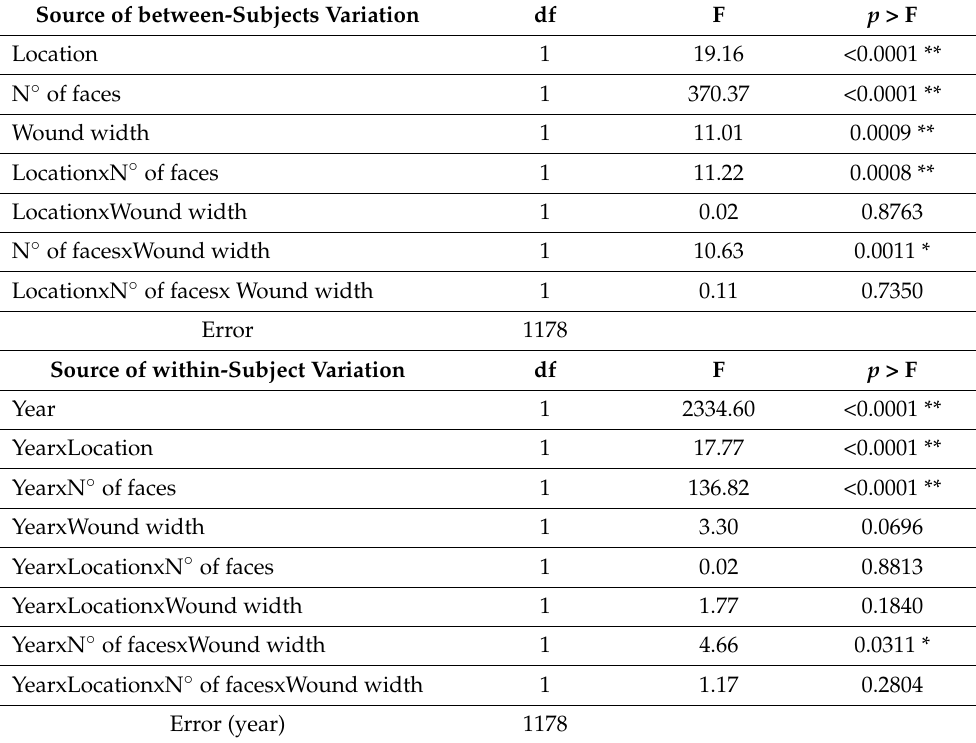
Table 3. Summary of the repeated measures model used to analyse resin production in maritime pine in two years (2017 and 2018) and in two locations (Caldas de Reis and Maceda). Degrees of freedom (df), F-ratios (F), associated probability levels ( p > F), significant effects (* p < 0.05), highly significant effects (** p <